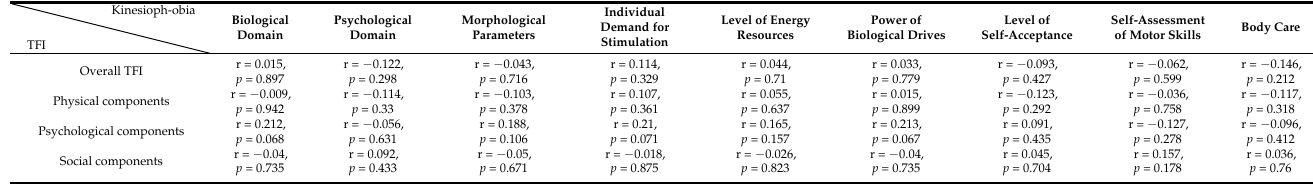
Table 6. Correlation between the TFI subscale and kinesiophobia in